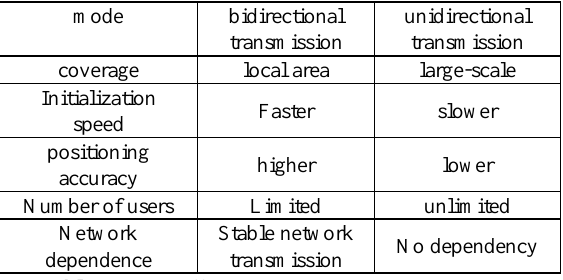
Table 1. main differences between CORS system and